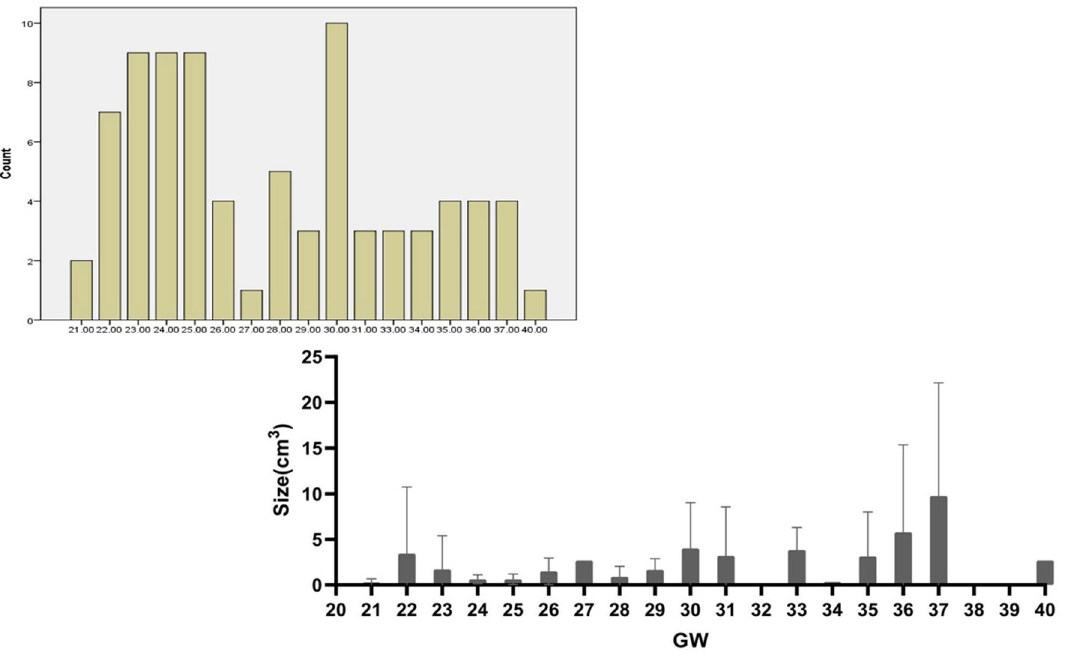
Figure 1. The flowchart of the recruited samples in this